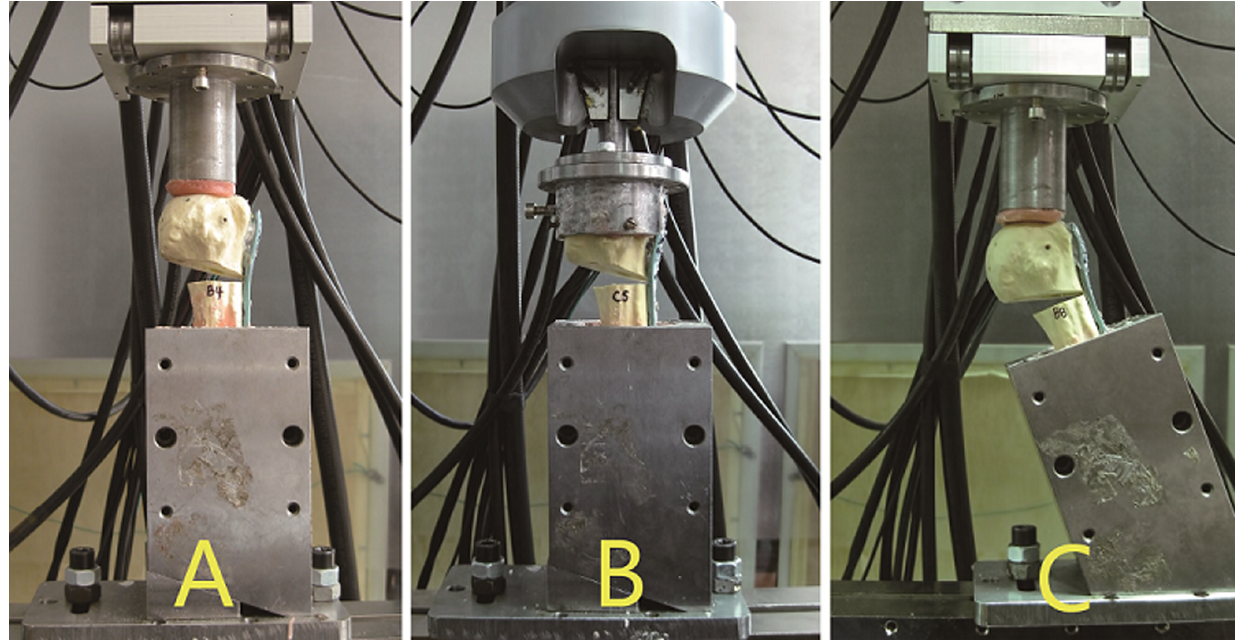
Figure 3. Mechanical test modes used to assess the (A) axial stiffness; (B) torsional stiffness; and (C) shear stiffness and load-to- failure of the plated humeral constructs.